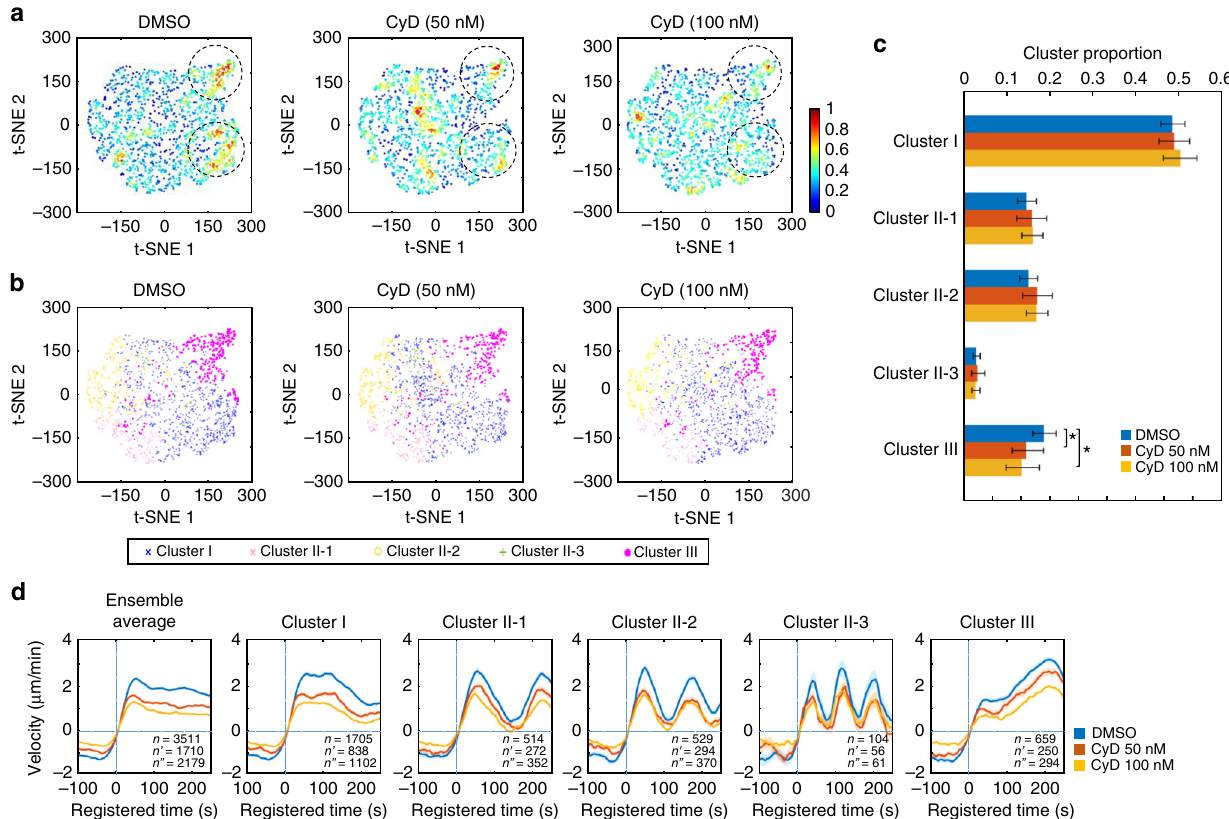
Fig. 6 Functional validation by pharmacological perturbation of VASP. a , b t-SNE plots of autocorrelation functions of protrusion velocity time series overlaid with the density of data ( a ) and cluster assignments ( b ). c Dose-response of the proportions of clusters to CyD. The error bars indicate 95% con fi dence interval of the mean of the cluster proportions. * p < 0.05 indicates the statistical signi fi cance by bootstrap sampling. d Ensemble averaged velocity time series of entire samples and averaged velocity time series sampled in each cluster in DMSO or Cytochalasin D (50 or 100 nM)-treated cells. All time series are registered with respect to protrusion onset ( t = 0). Solid lines indicate population averages. Shaded error bands indicate 95% con fi dence intervals of the mean computed by bootstrap sampling. n, n' and n" indicate the number of time series sampled in each cluster for DMSO, CyD 50nM, and CyD 100nM, respectively. The numbers of cells used in these analyses are 22 (DMSO), 16 (CyD 50 nM) and 20 (CyD 100 nM),